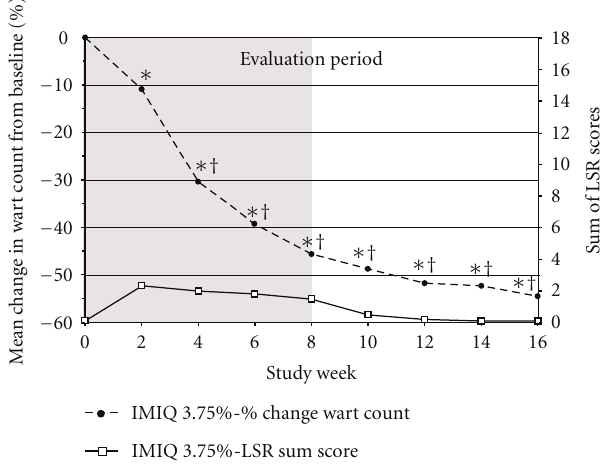
Figure 4: Change in wart count compared with baseline (left axis, circle, mean, ITT, last observation carried forward) versus local skin reaction (LSR) sum score (right axis, square, mean, observed) over time for imiquimod 3.75% during the evaluation phase. Maximum LSR sum score = 18. Shaded box indicates treatment period of up to 8 weeks. P values were calculated using analysis of covariance, controlling for baseline wart count, and analysis site. ∗ indicates statistically significant for active versus placebo, and † for imiquimod 3.75% versus 2.5%, using Hochberg’s modified Bonferroni